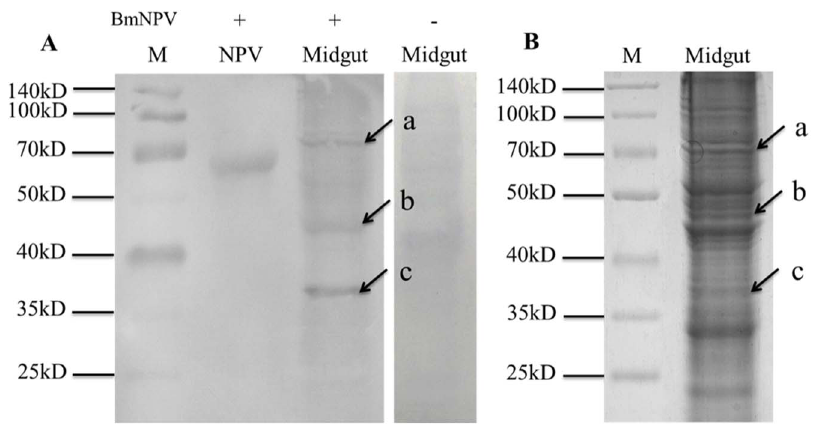
Fig. 1. Virus binding experiment on total proteins of B. mori midgut resolved by SDS-PAGE. A) Virus overlay binding experiment. B) Separation of B. mori midgut total proteins by SDS-PAGE. M indicated the standard prestained protein molecular weight marker (Thermo Scientific), NPV was set as positive control, Midgut referred to B. mori midgut total proteins separated by SDS-PAGE, and the right lane in A) was the negative control that overlaid in binding buffer without BmNPV particles before incubated with monoclonal antibodies against baculovirus gp64. The plus and minus signs on the top meant membranes incubated with or without BmNPV particles. Arrows named a, b, c in A) and B) referred to the detected bands on PVDF membrane and the corresponding proteins in gel.